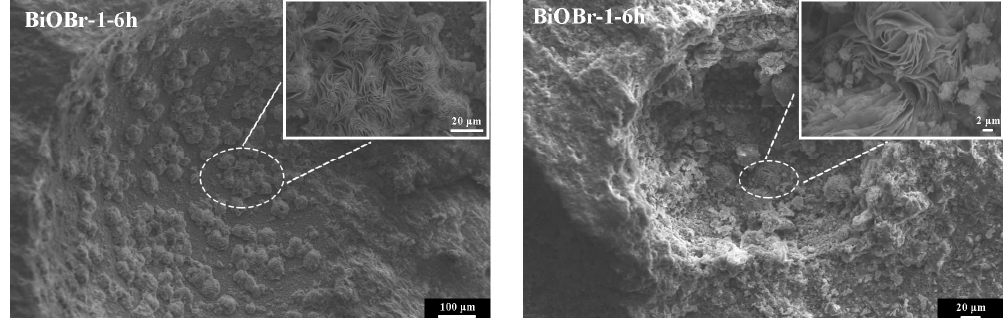
Figure 7. BiOBr crystals inside the pores of sample BiOBr-1-6h. Figure 8. SEM image and EDS-mapping images of BiOBr crystals.